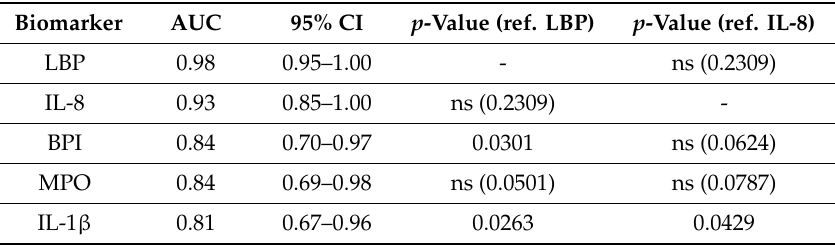
Table 2. ROC curve analysis for all IPA